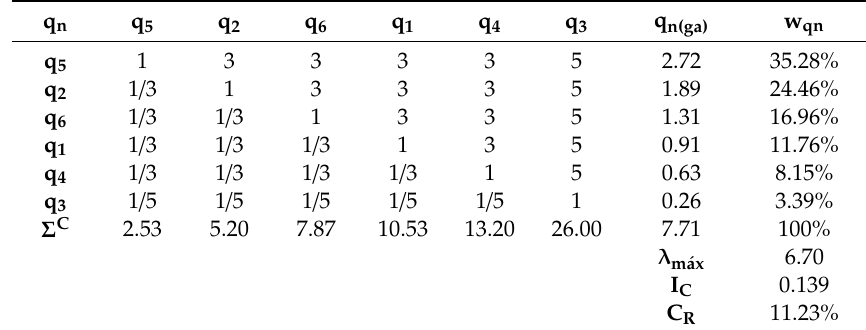
Table A6. To define the importance (weight) between the water quality parameters—q n (criterial), I R = 1.24 (for n = 6).